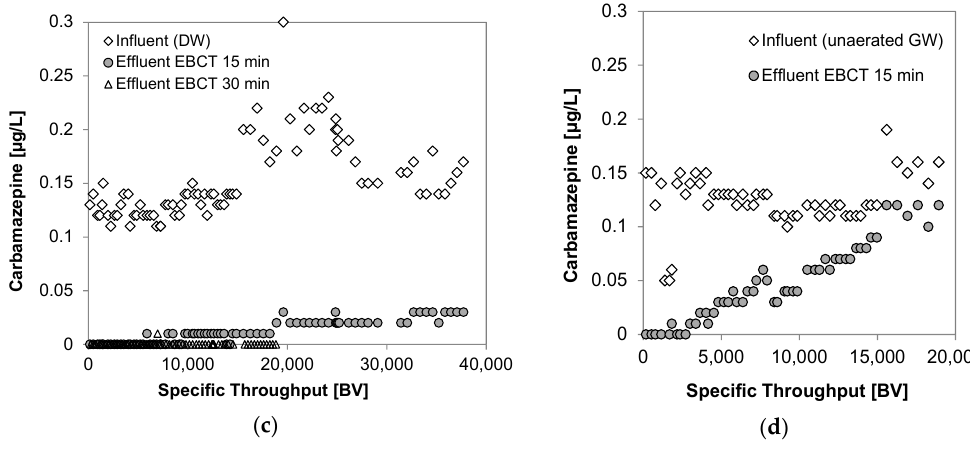
Figure 7. Breakthrough curves for ( a , b ) oxypurinol and ( c , d ) carbamazepine in two fixed-bed adsorbers in series fed with drinking water (left) and a single fixed-bed adsorber fed with un-aerated groundwater (right).